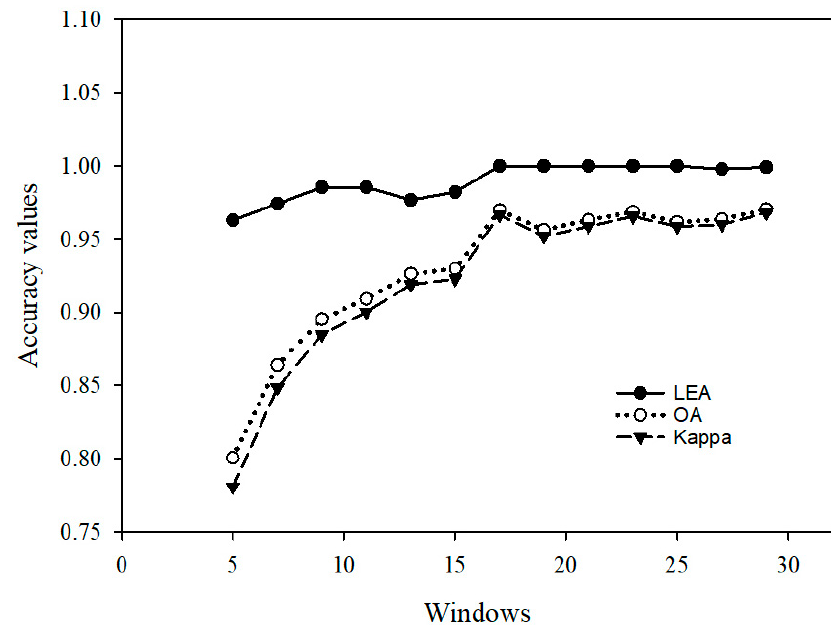
Figure 10. Changes of the classification accuracy using CBAM-P-Net (Parallel).